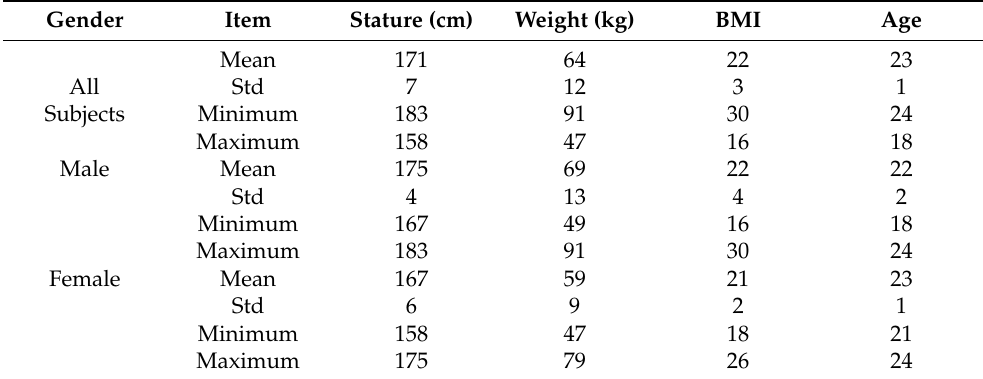
Table 1. Demographic and anthropometric characteristics of